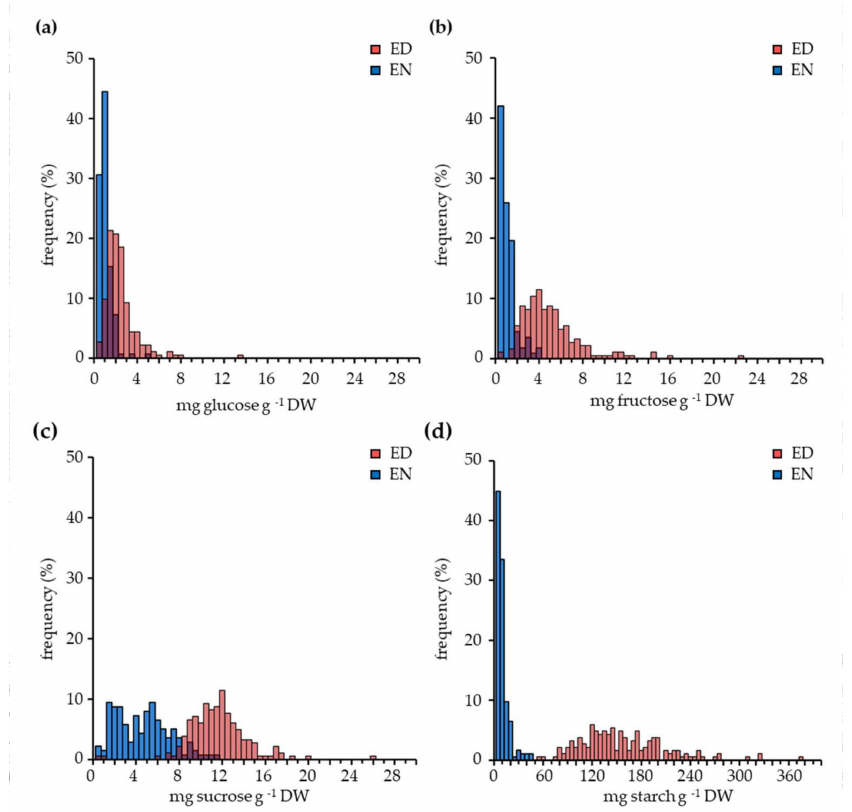
Figure 1. Frequency distribution of diel leaf glucose ( a ), fructose ( b ), sucrose ( c ), and starch ( d ) contents in 185 individual genotypes of the variety Munida , sampled at the end of the day (ED) and at the end of the night (EN). For measured water-soluble carbohydrate (WSC) contents, the scale was kept the same between the graphs for comparison. For ( a – c ), the purple sections of each histogram indicate regions where the frequency distribution of ED and EN overlap; DW: dry